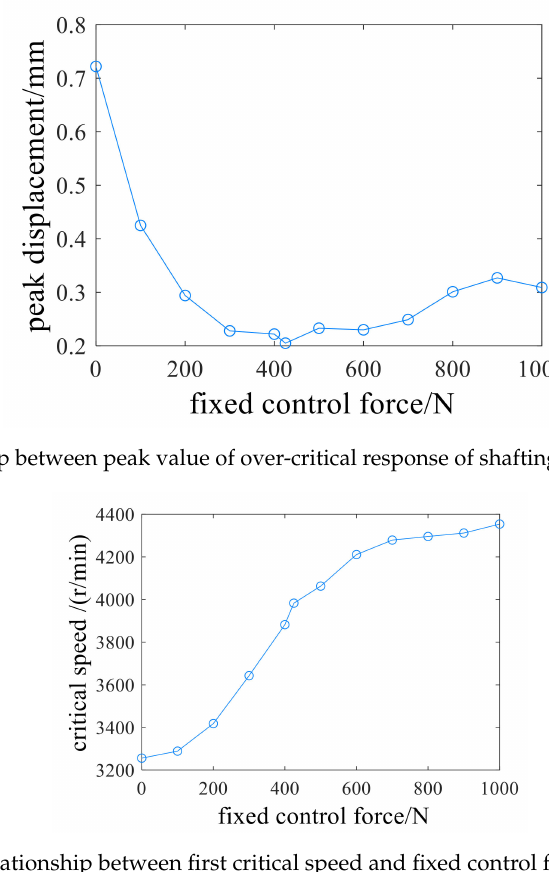
Figure 9. Relationship between first critical speed and fixed control force of